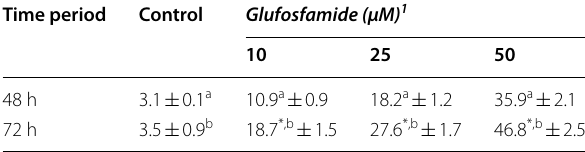
Table 2 Effects of glufosfamide on the frequency of apoptosis in HepG2 cells Table 3 Effects of ifosfamide on the frequency of apoptosis in